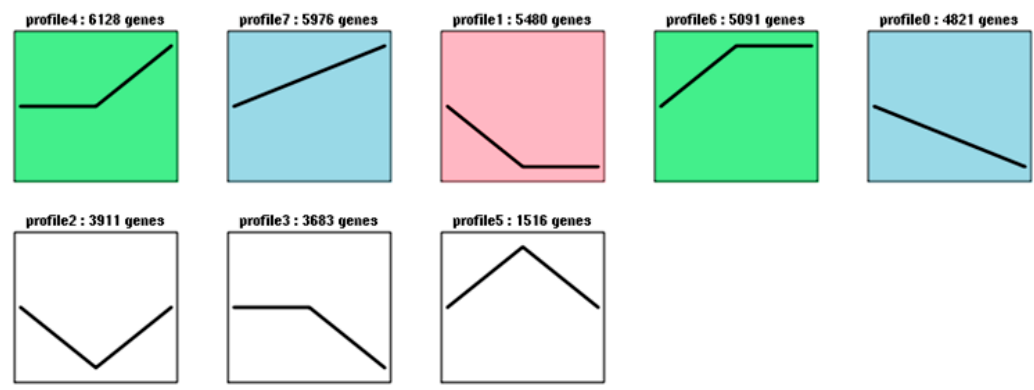
Figure 4. Cluster analysis of the differentially expressed genes. The profiles in color indicate statistical significance ( p < 0.01). The number on the topis the profile number and assigned genes. The black lines represent the model expression profiles of different genes.